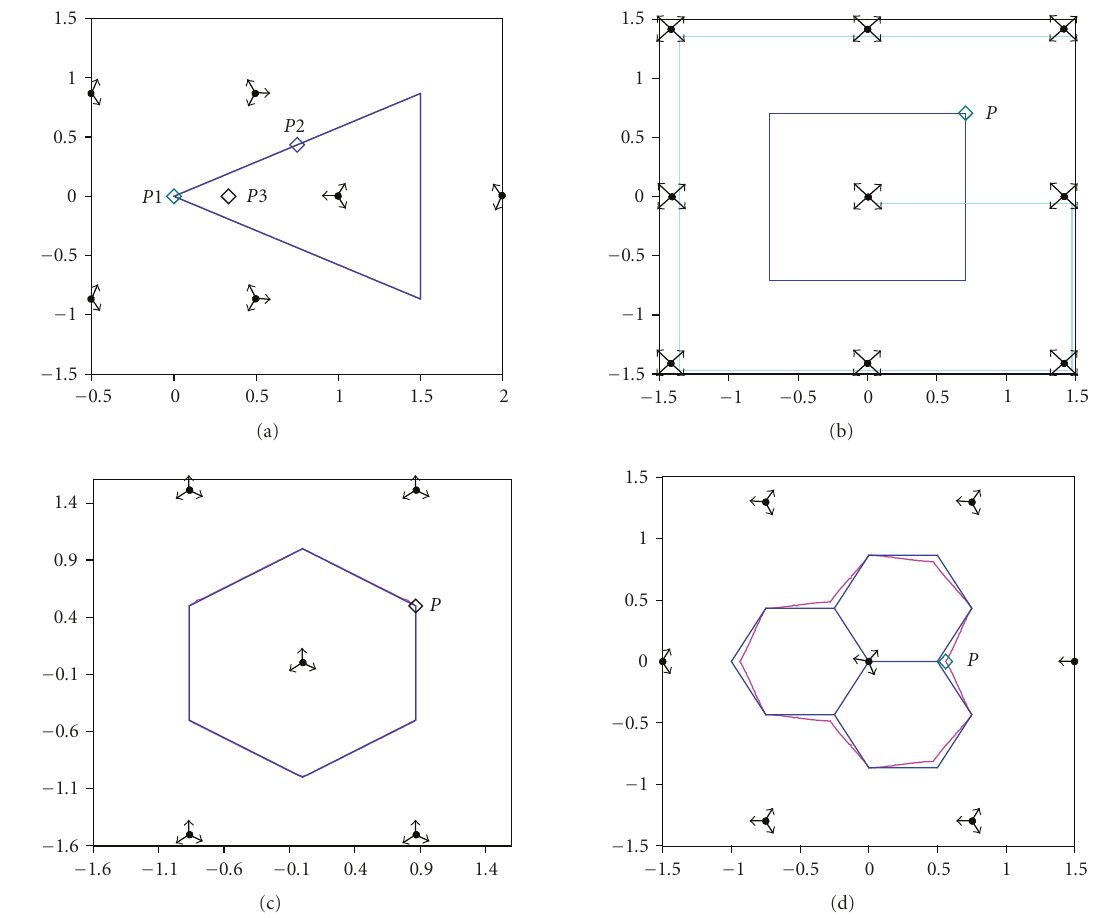
Figure 6: Site dominance area shape for di ff erent layouts (slope = 40dB/dec).